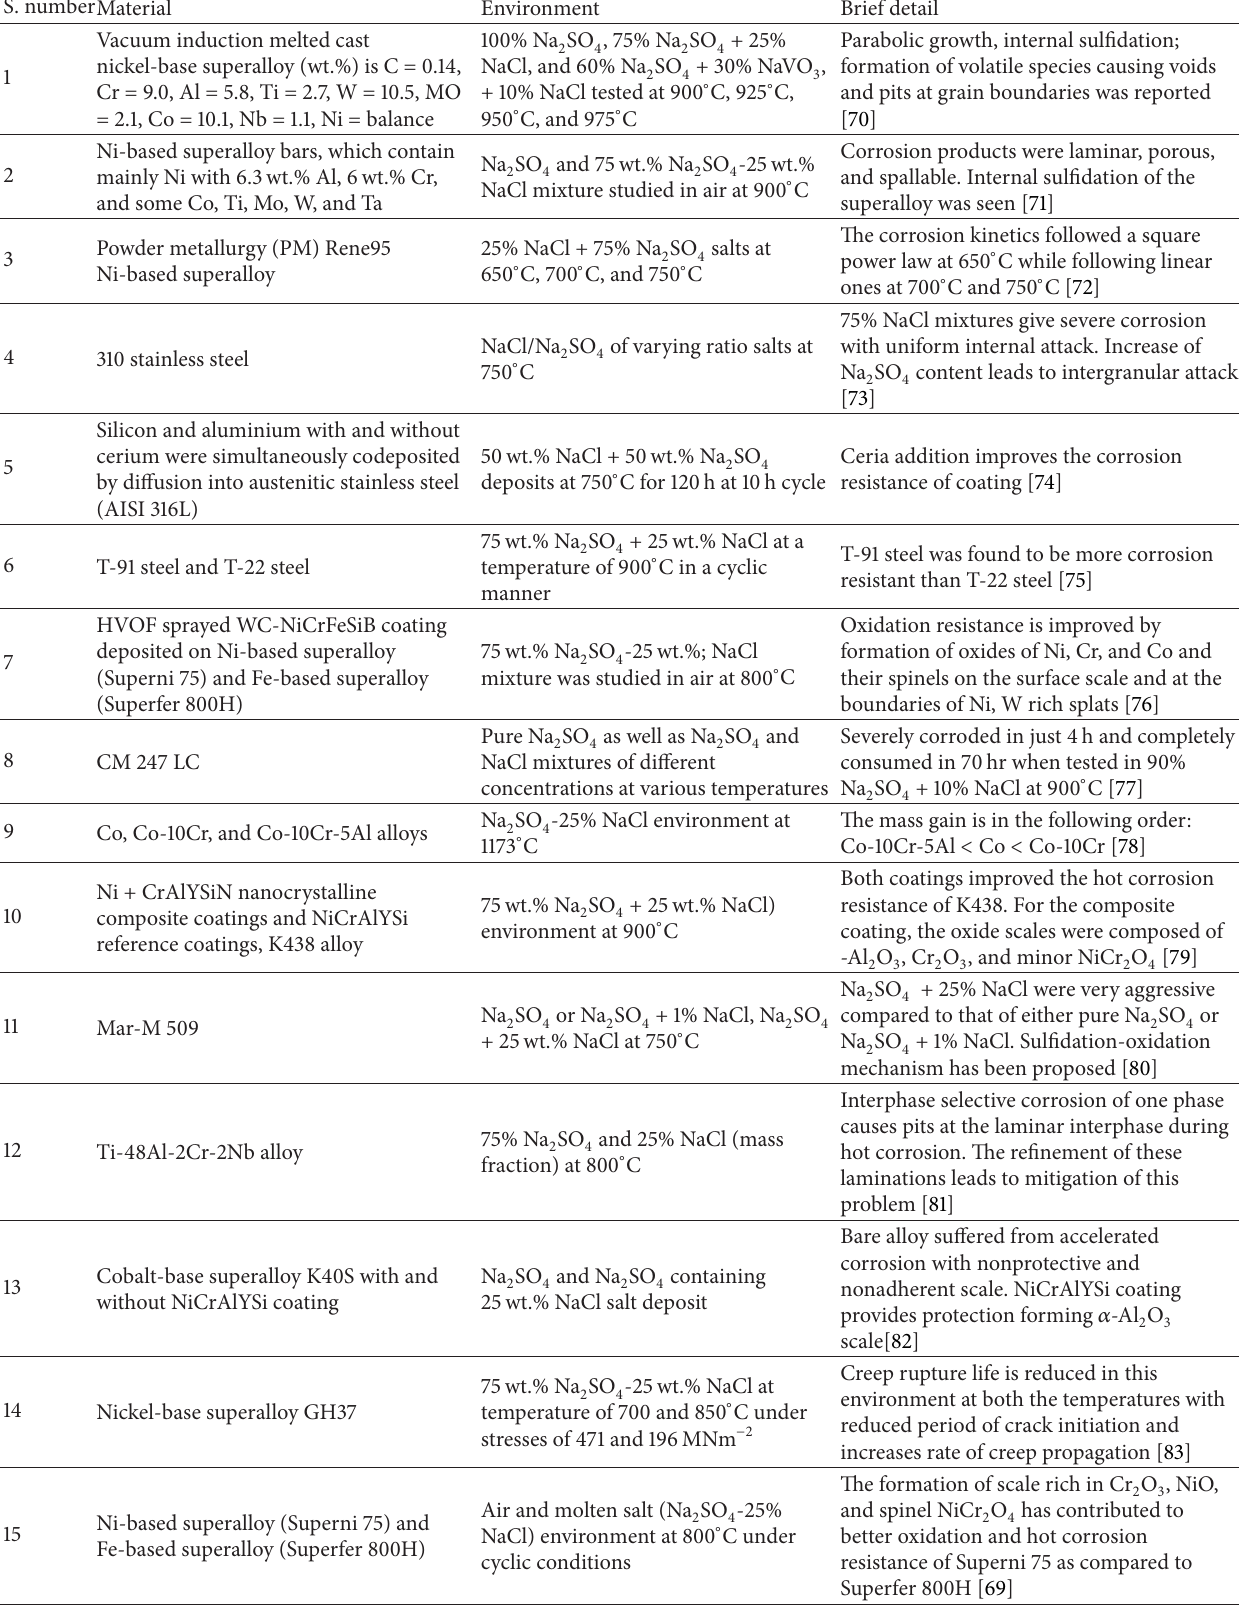
Table 1: A summary of corrosion studies on some alloys and coatings under chlorides and sulphates containing environment. S. numberMaterial Environment Brief detail